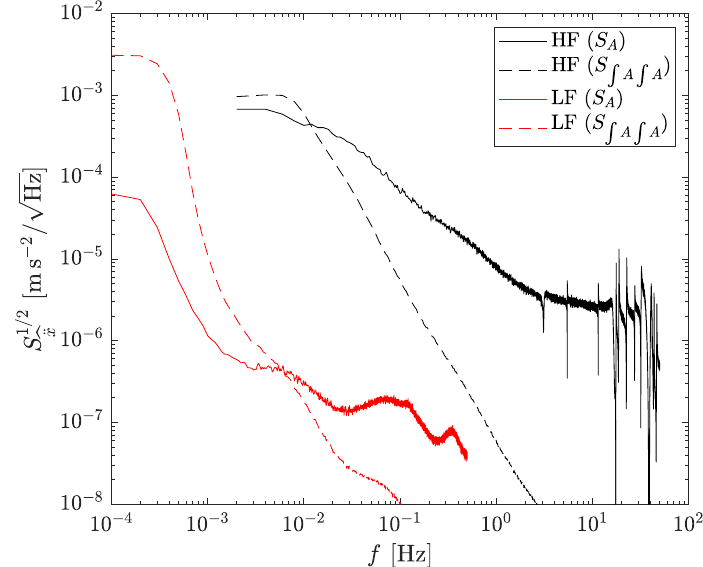
Figure 4. Predicted linear acceleration noise when using HF (black) and LF (red) accelerometers. Solid traces are the first term in Equation (9), while dashed traces are the contributions of the cross terms due to leakage from angular velocity noise. The effect becomes dominant for f < 6mHz in the LF optomechanical resonator, and barely visible in the HF